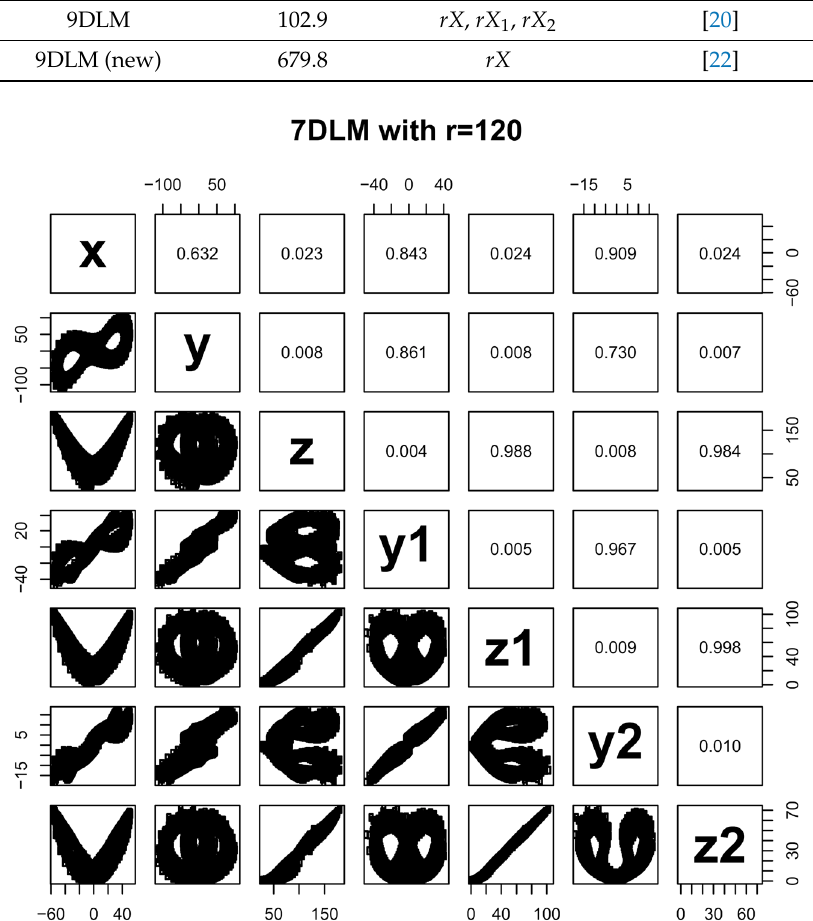
Figure 4. A matrix of scatter plots for the 7DLM with its seven variables, as listed in the principal diagonal. r and σ are 120 and 10, respectively. Each of the cells above (below) the diagonal provides a Pearson correlation coefficient (scatter plot) between the two variables. Scale dependence is indicated by high Pearson correlation coefficients, as well as the linear relationship in scatter plots (courtesy of [20]; See details in